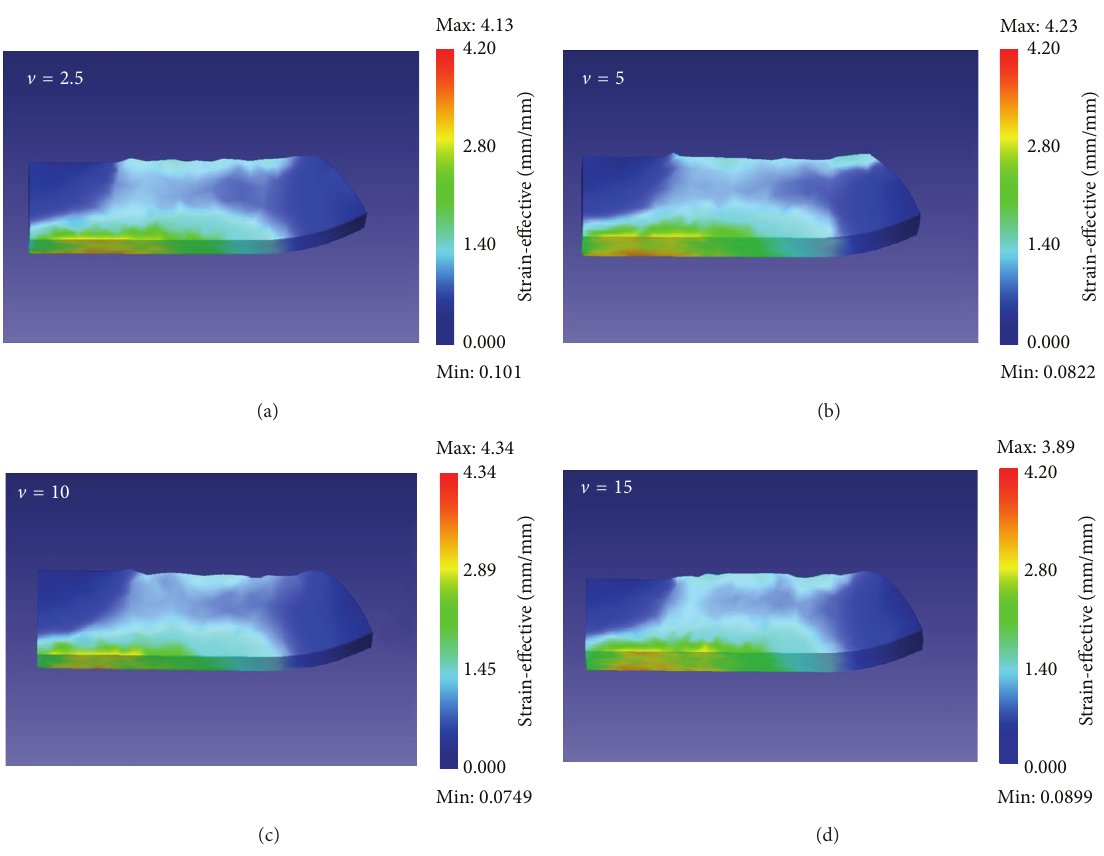
Figure 7: The effective strain distribution of the workpiece after ECAE process with different extrusion velocity: (a) V = 2.5 , (b) V = 5 , (c) V = 10 , and (d) V = 15 .